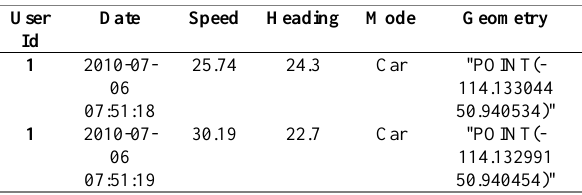
Table 3. Attributes of collected data. User